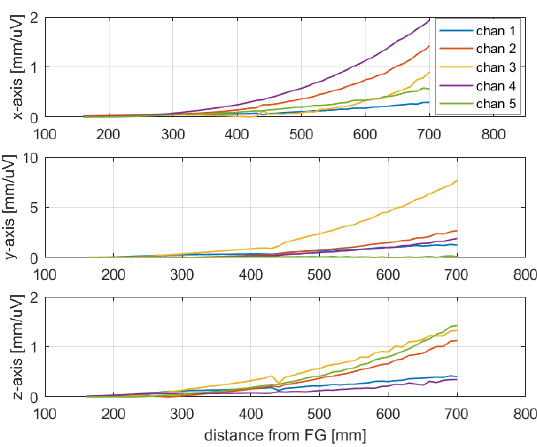
Figure 7. Elements of the pseudoinverse of the Jacobian matrix vs distance from the FG.